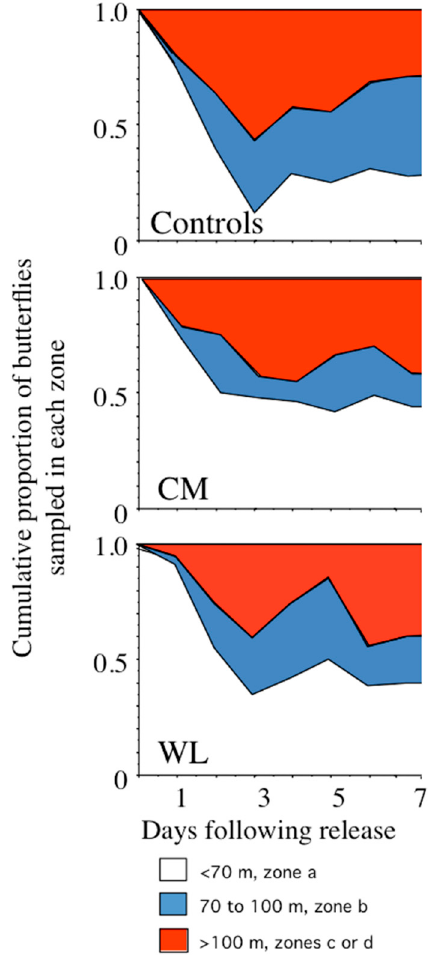
Figure 2. The cumulative proportion of resampled butterflies in zone a, which was nearest to the release point, to zones c and d, which were furthest from the release point, on days 1–7 following the releases in October. The zones refer to concentric circles measured from the release point in the middle of zone a (see Figure 1). Dispersal from the center is evident from a diminishing proportion of butterflies in zone a, and increasing proportions of butterflies in zone b or zones c and d. Control butterflies dispersed faster than either center of mass (CM) or weight-loaded (WL) butterflies, particularly during the first three days following release. WL, group of butterflies for which weights were added near to cm body ; CM, group of butterflies for which weights were added posterior to cm body .